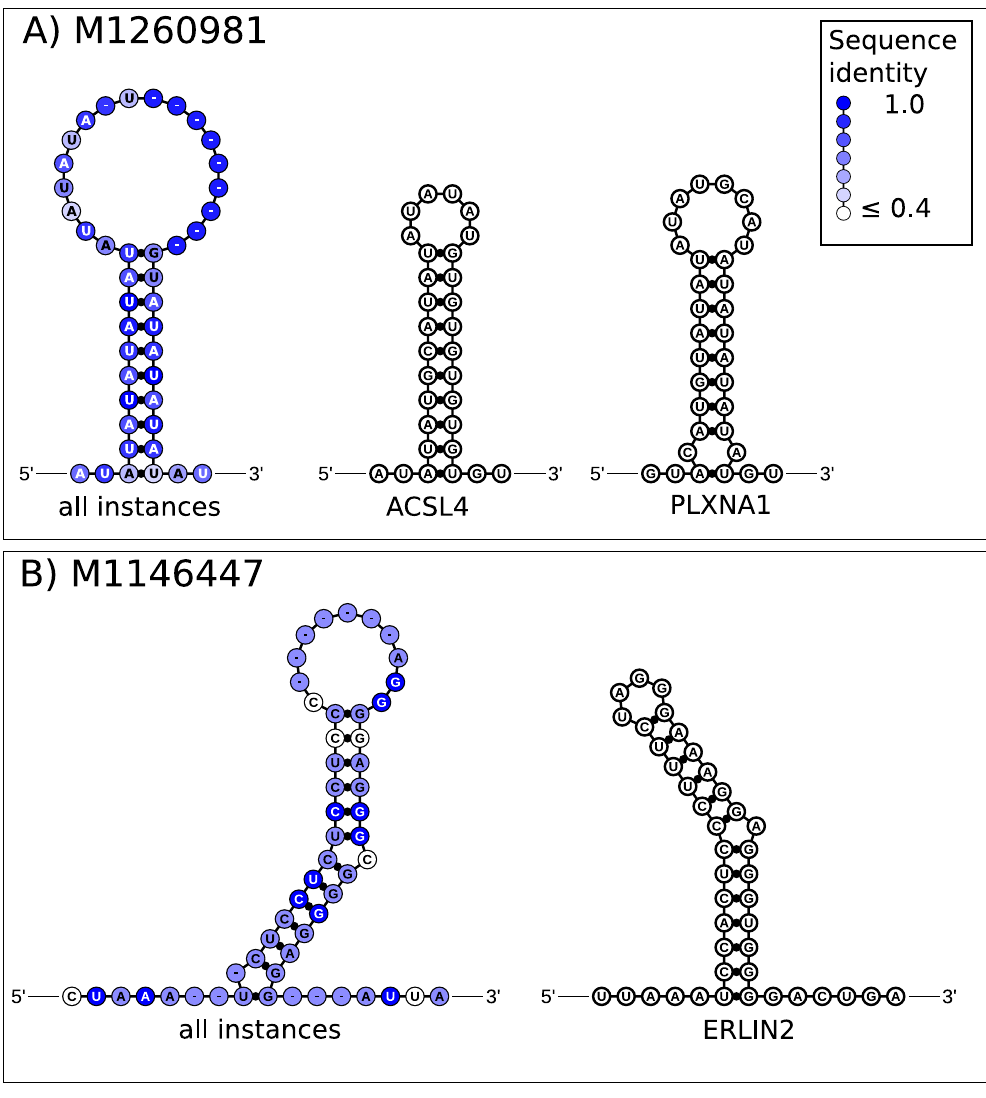
Figure 4. Examples of reoccurring RNA structure motifs. Each panel shows the consensus structure based on the predicted instances of the corresponding conserved RNA structure (CRS) motif and instances of the CRS in brain related genes. The sequence identity is computed over the predicted instances of the motif and given by a white to blue color gradient. RNA secondary structure diagrams were drawn with RNAfdl 104